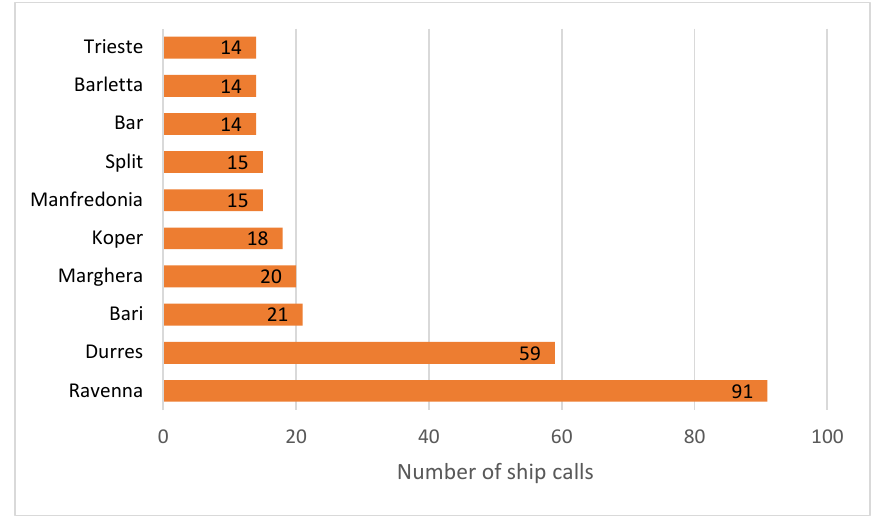
Figure A12. Frequency of ship calls where the last port of call was the Adriatic Sea port.